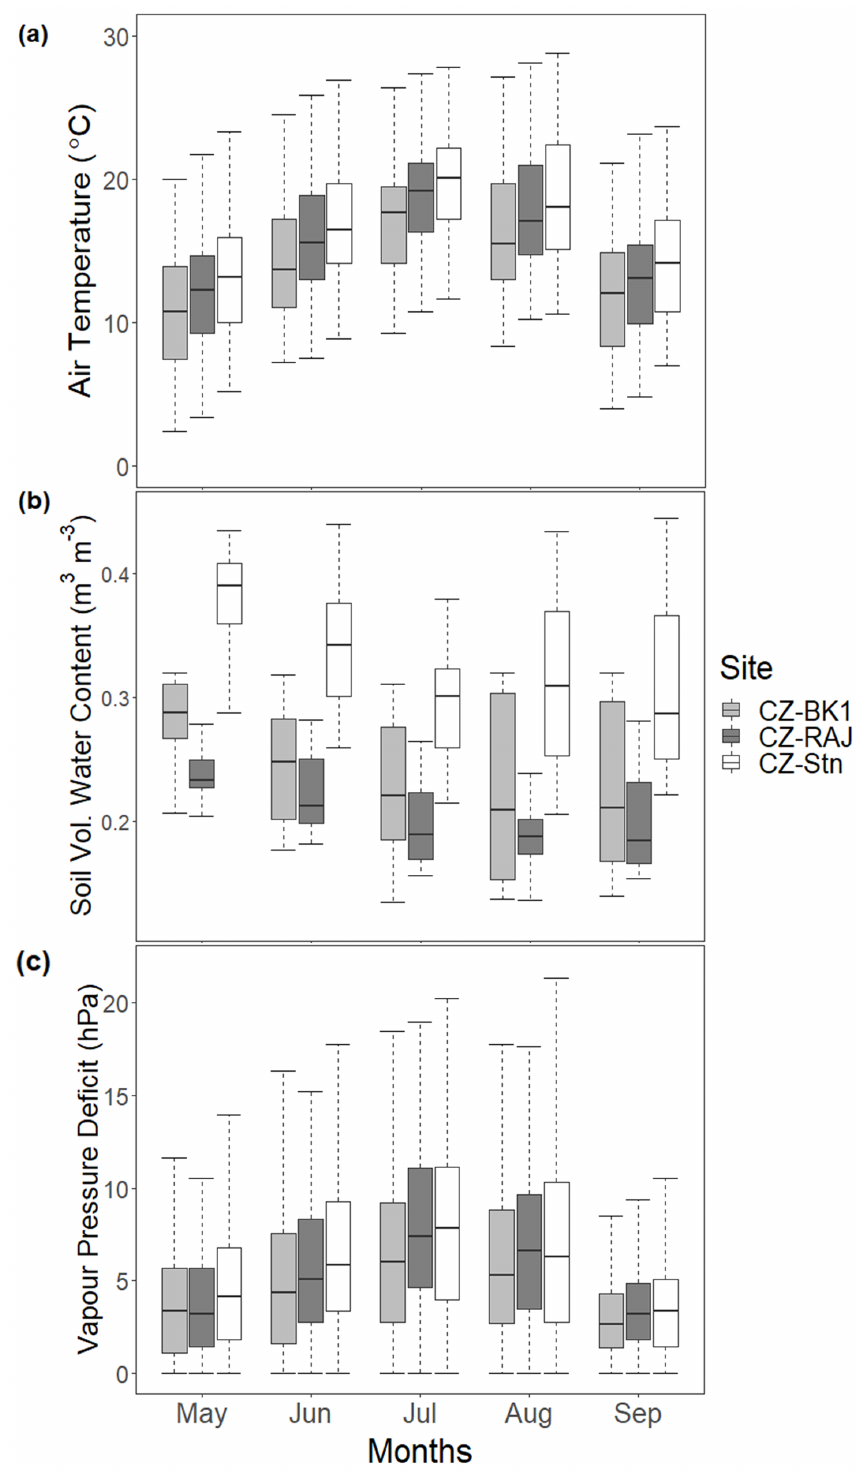
Figure 1. Monthly averages of ( a ) air temperature, ( b ) the soil volumetric water content, and ( c ) vapour pressure deficit for May–September of 2012–2016 in the spruce forest in Bílý K˘rí˘z (CZ-BK1), Rájec (CZ-RAJ) and the beech forest Štítná (CZ-Stn) sites. The thick horizontal line in the box plot represents the median value and the box indicates the upper and lower quartiles, with the vertical dotted lines representing the minimum and maximum values. The error bars (whiskers) portray the standard